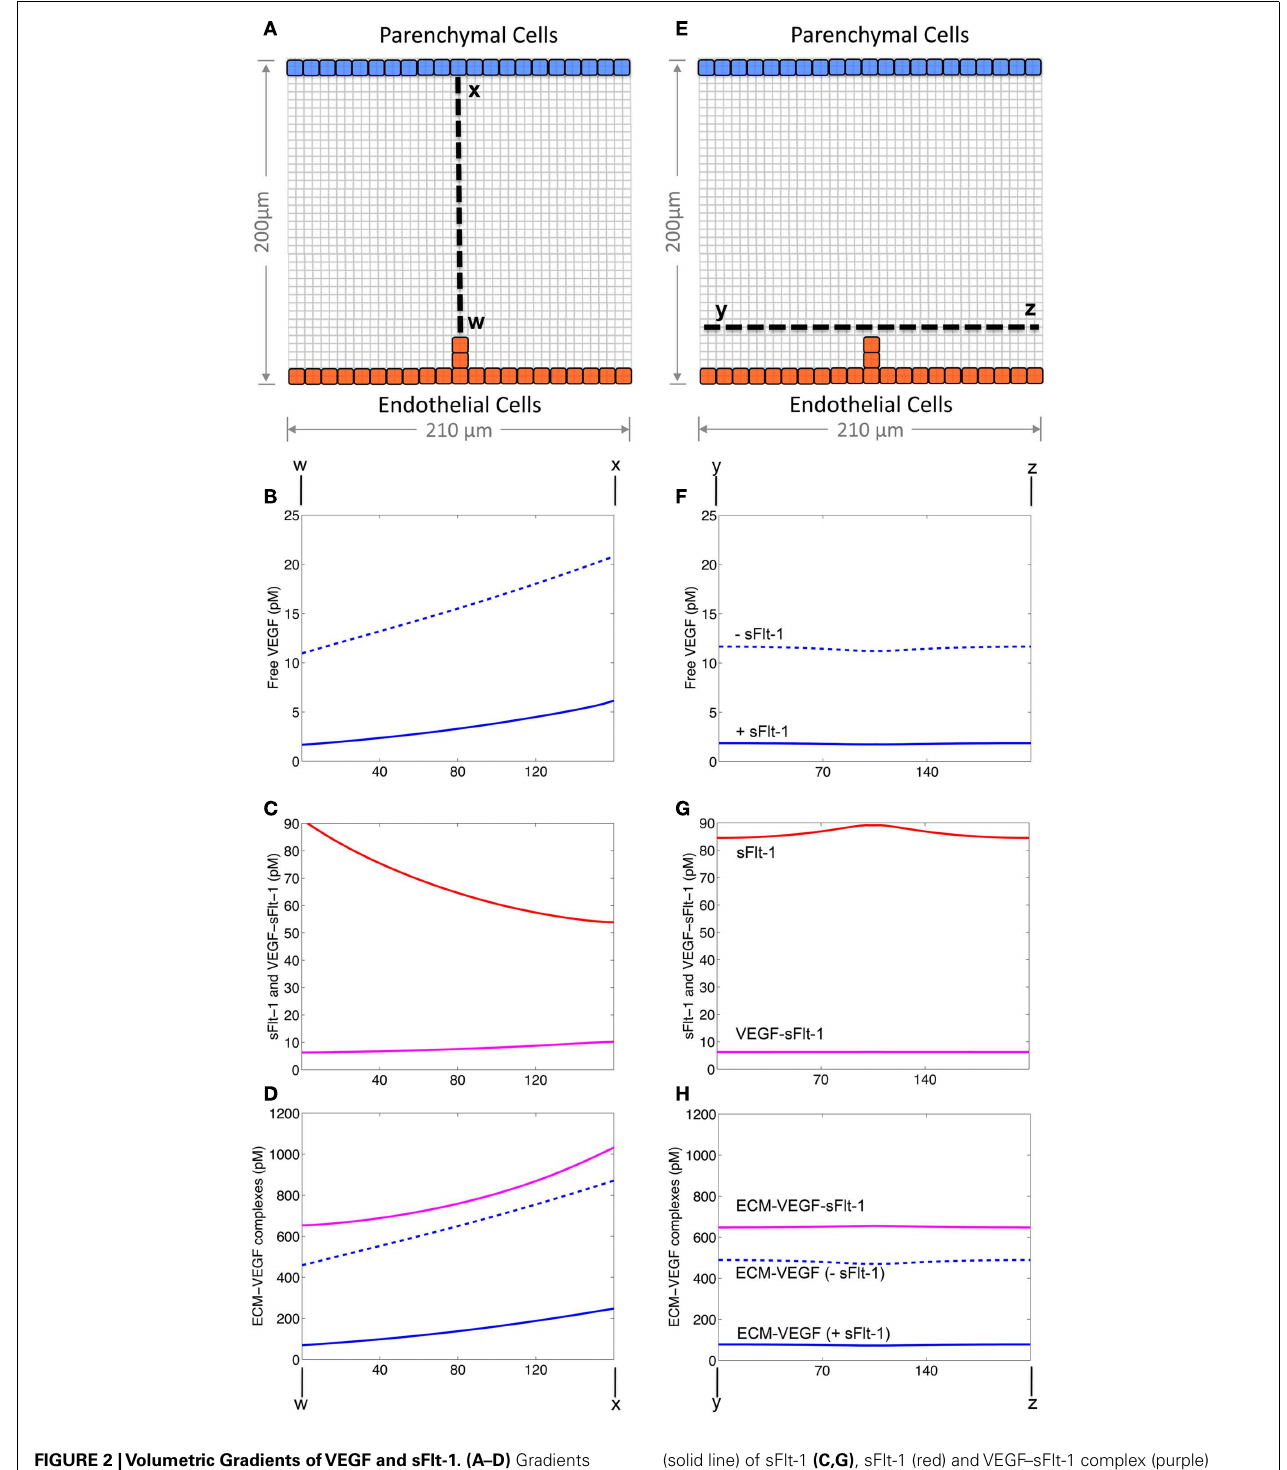
FIGURE 2 |Volumetric Gradients ofVEGF and sFlt-1. (A–D) Gradients ofVEGF, sFlt-1, and their complexes along a line from the sprout leading edge to the parenchymal cell wall. (E–H) Gradients ofVEGF, sFlt-1, and their complexes along a transverse line in front of the sprout leading edge. (B,F) VEGF gradients in the absence (dotted line) and presence